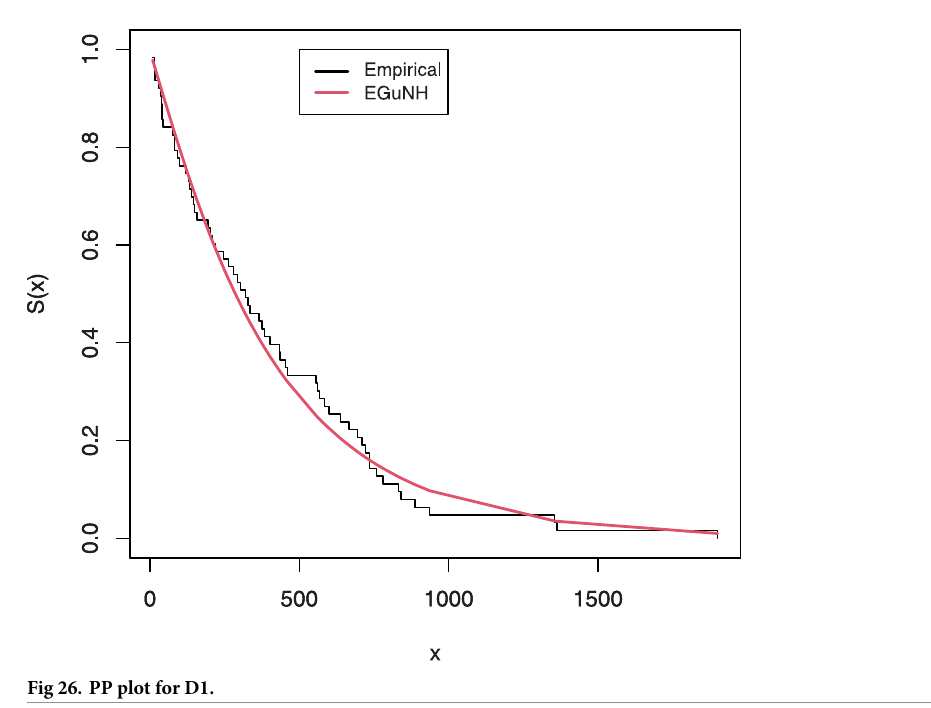
Fig 26. PP plot for